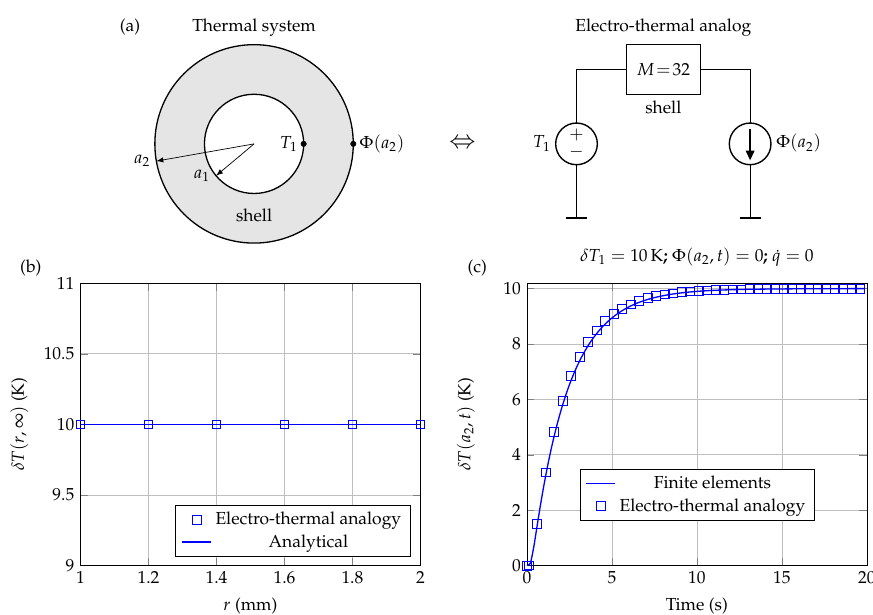
Figure 9. ( a ) Electro-thermal modeling of a shell subjected to Dirichlet boundary condition ( δ T 1 = 10K) at r = a 1 and homogeneous Neumann condition at r = a 2 : Φ ( a 2 ) = ( ∂ r T ) state temperature profile through the shell. ( c ) Temperature variations as a function of time at r = a 2